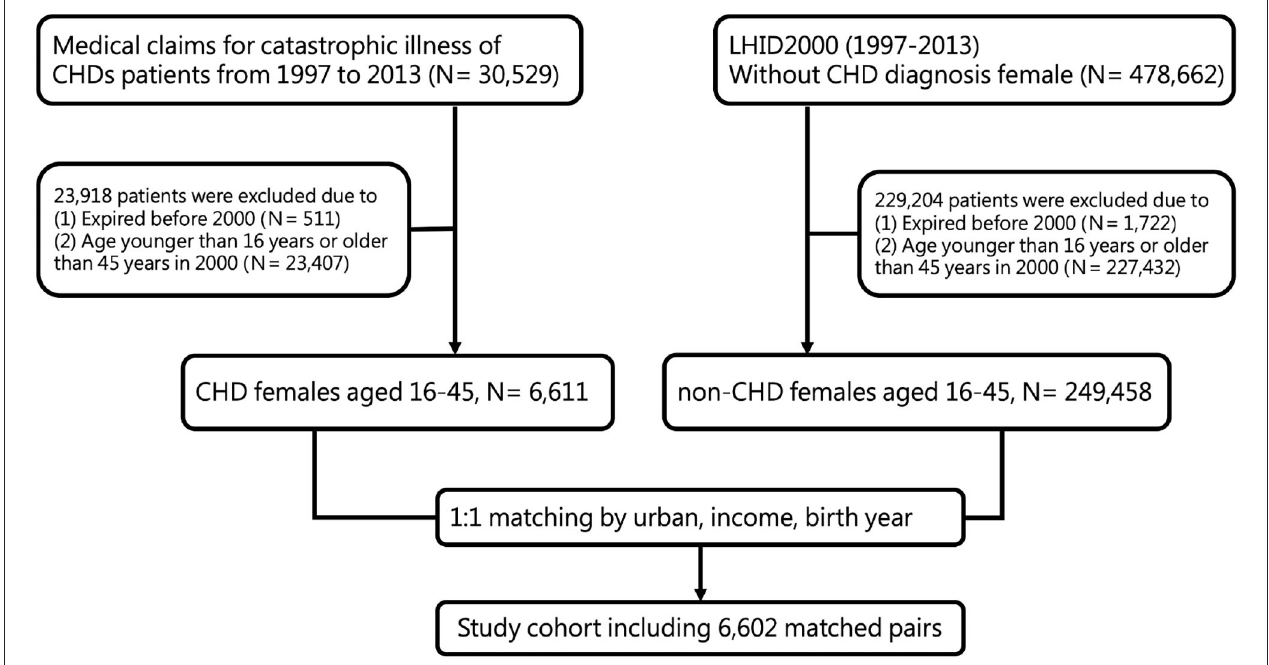
FIGURE 1 | The flow chart of case selection and exclusion of women with a history of